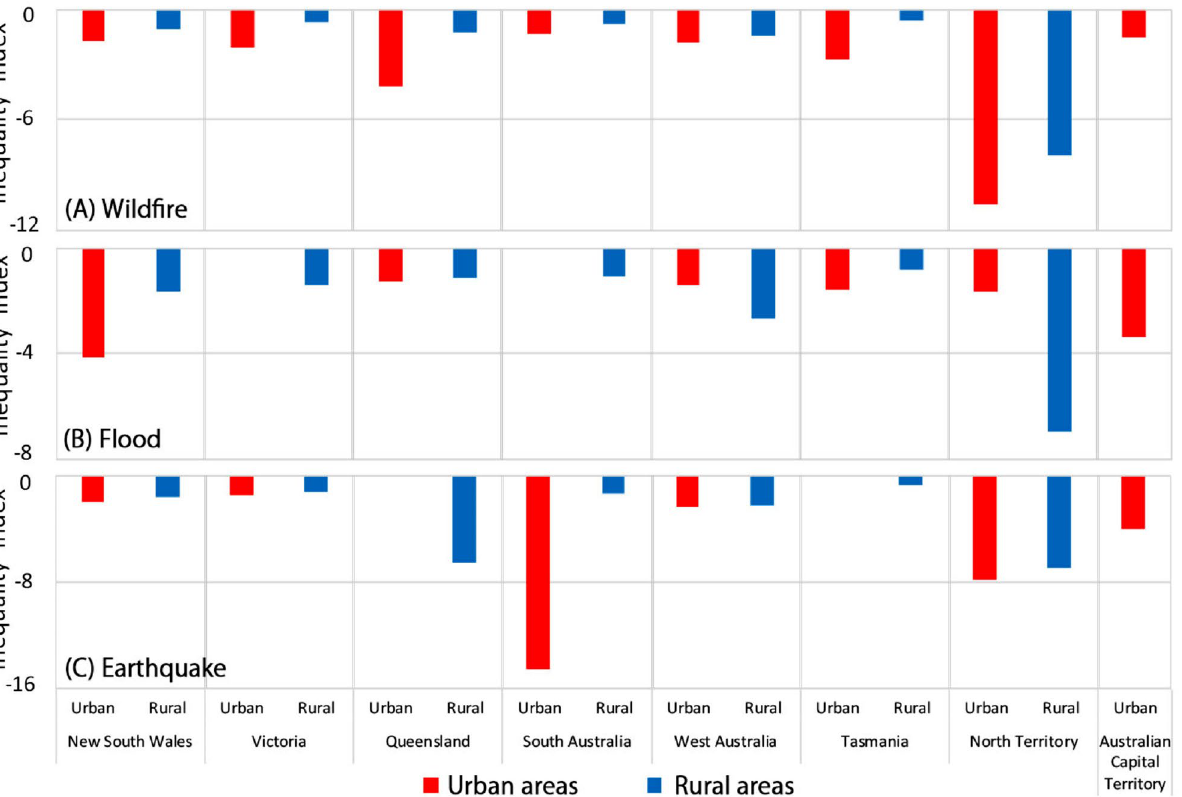
Figure 9. Inequality index of vulnerability in hazard-affected and non-hazard areas across urban and rural space. Here we only present the medium scenario ( k =0.5) and the statistical summary of the inequality index on three levels of k (0.25, 0.5, and 0.75) is provided in Supplementary Table S14. For wildfire (Fig. 9A), the inequality index in the urban areas of all states are larger than that their rural counterparts, reflecting vulnerability in wildfire-affected areas tends to be less equally distributed in urban than rural areas. Across states, the inequality of vulnerability in wildfire-affected areas is more obvious in Northern Territory (− 10.634 in urban areas vs. − 7.927 in rural areas) than other states. For flood (Fig. 9B), the magnitudes of the inequality index in the urban areas are larger than that its rural counterparts in New South Wales (− 4.168 vs. − 1.634), Queensland (− 1.269 vs. − 1.141), Tasmania (− 1.594 vs. − 0.798), but smaller in West Australia (− 1.376 vs. − 2.664) and Northern Territory (− 1.619 vs. − 6.985). It means that the inequality of vulnerability in flood- affected areas in urban areas of New South Wales, Queensland, Tasmania is more obvious than their rural counterparts. In particular, the inequality of vulnerability in flood-affected areas is more obvious in the rural areas of Northern Territory (− 6.985) and Sydney (− 4.168) than other regions (− 0.798 to − 3.387). For earthquake (Fig. 9C), the inequality of vulnerability in earthquake-affected areas in urban areas of all states is more obvious than their rural counterparts. In particular, the inequality of vulnerability in earthquake-affected areas in Adelaide (− 14.519), rural Queensland (− 6.533), and North Territory (− 7.903 vs. − 6.928) are more obvious than other